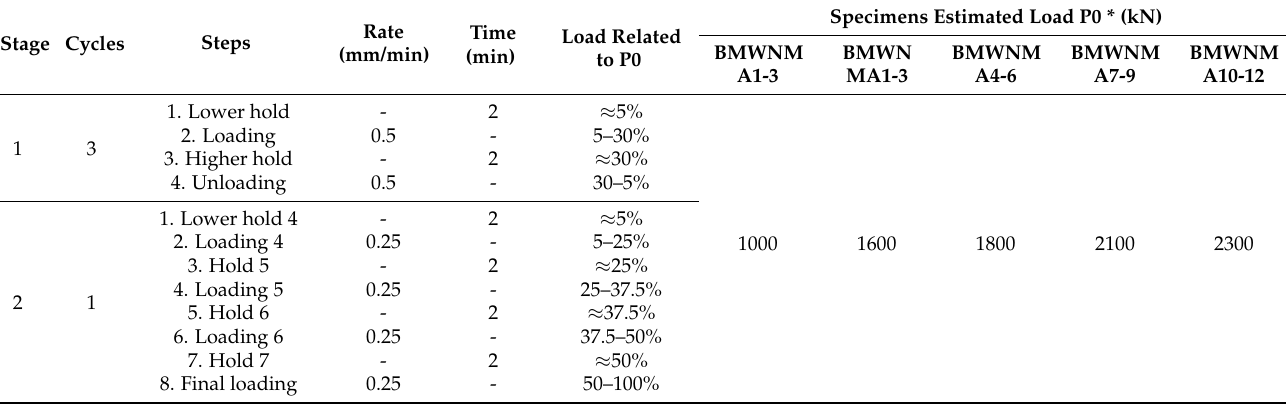
Table 4. Summary of the tests’